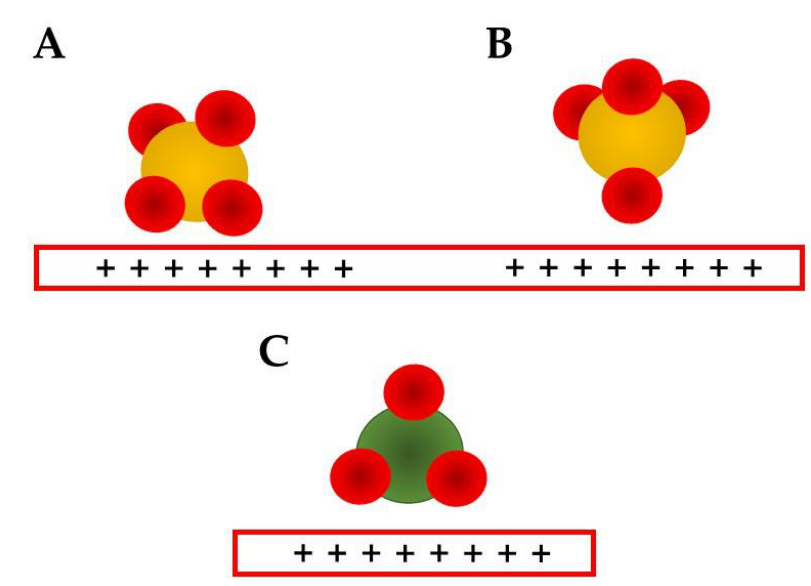
Figure 7. Proposed anion adsorption conformations for sulfate ( A , B ) and nitrate ( C )